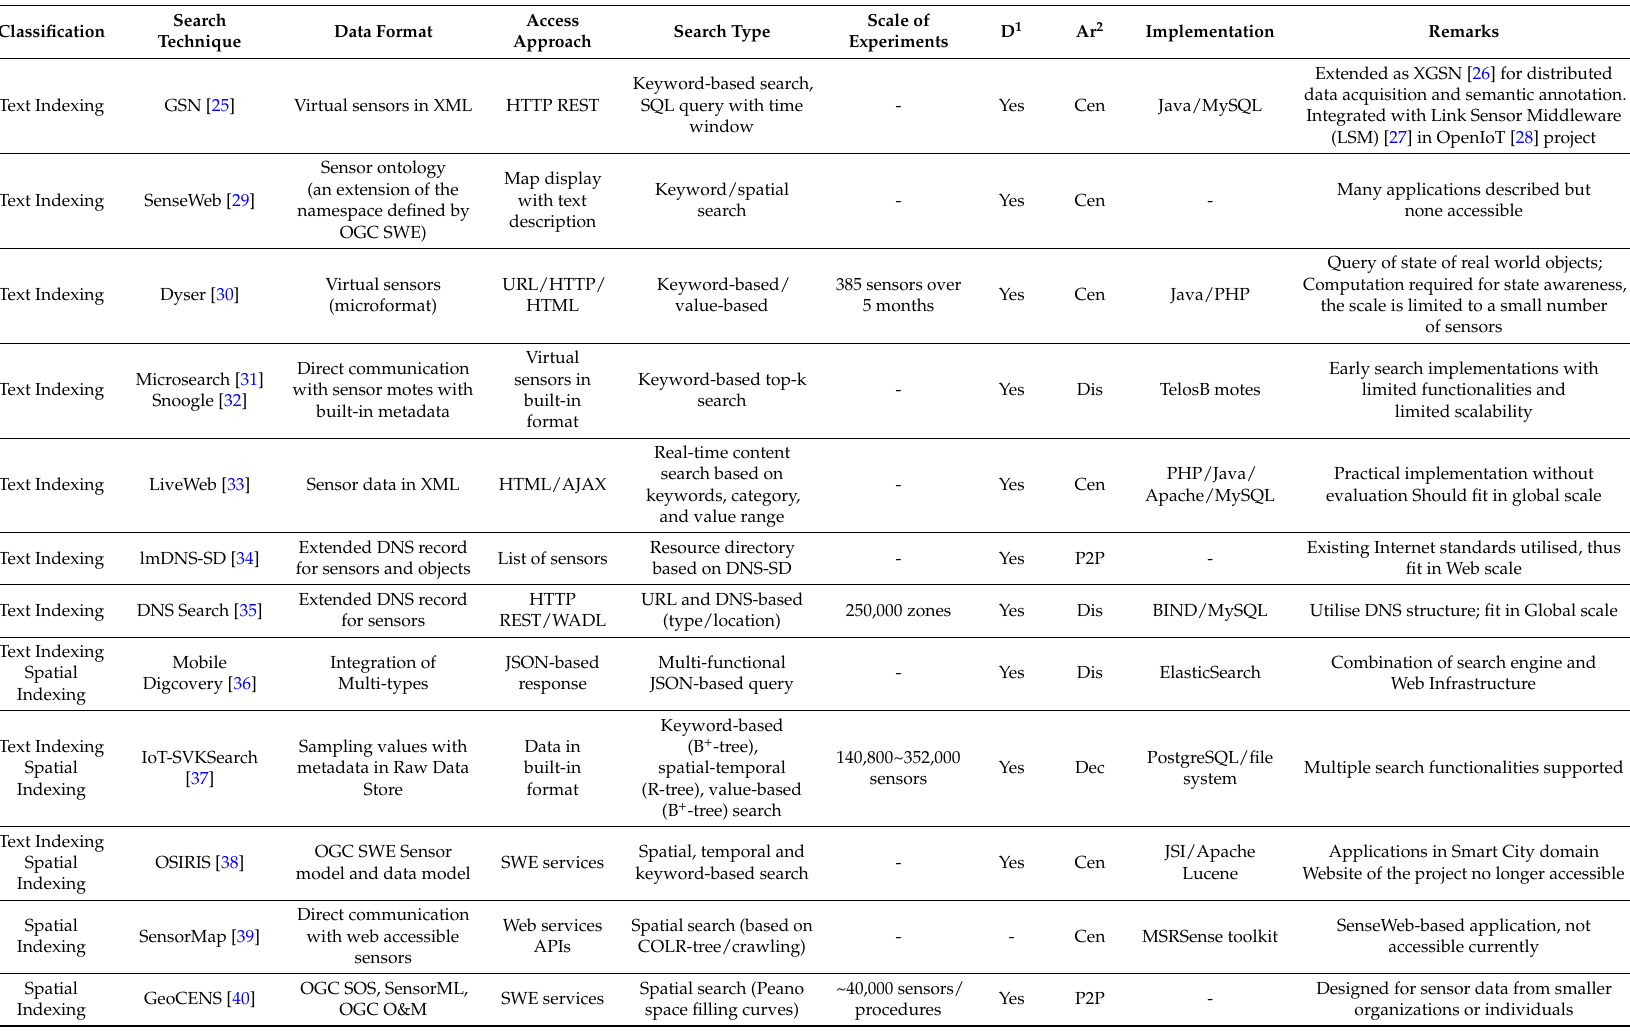
Table 2. Comparison of Search Techniques According to Basic Principles Classification (Abbreviations are listed in the